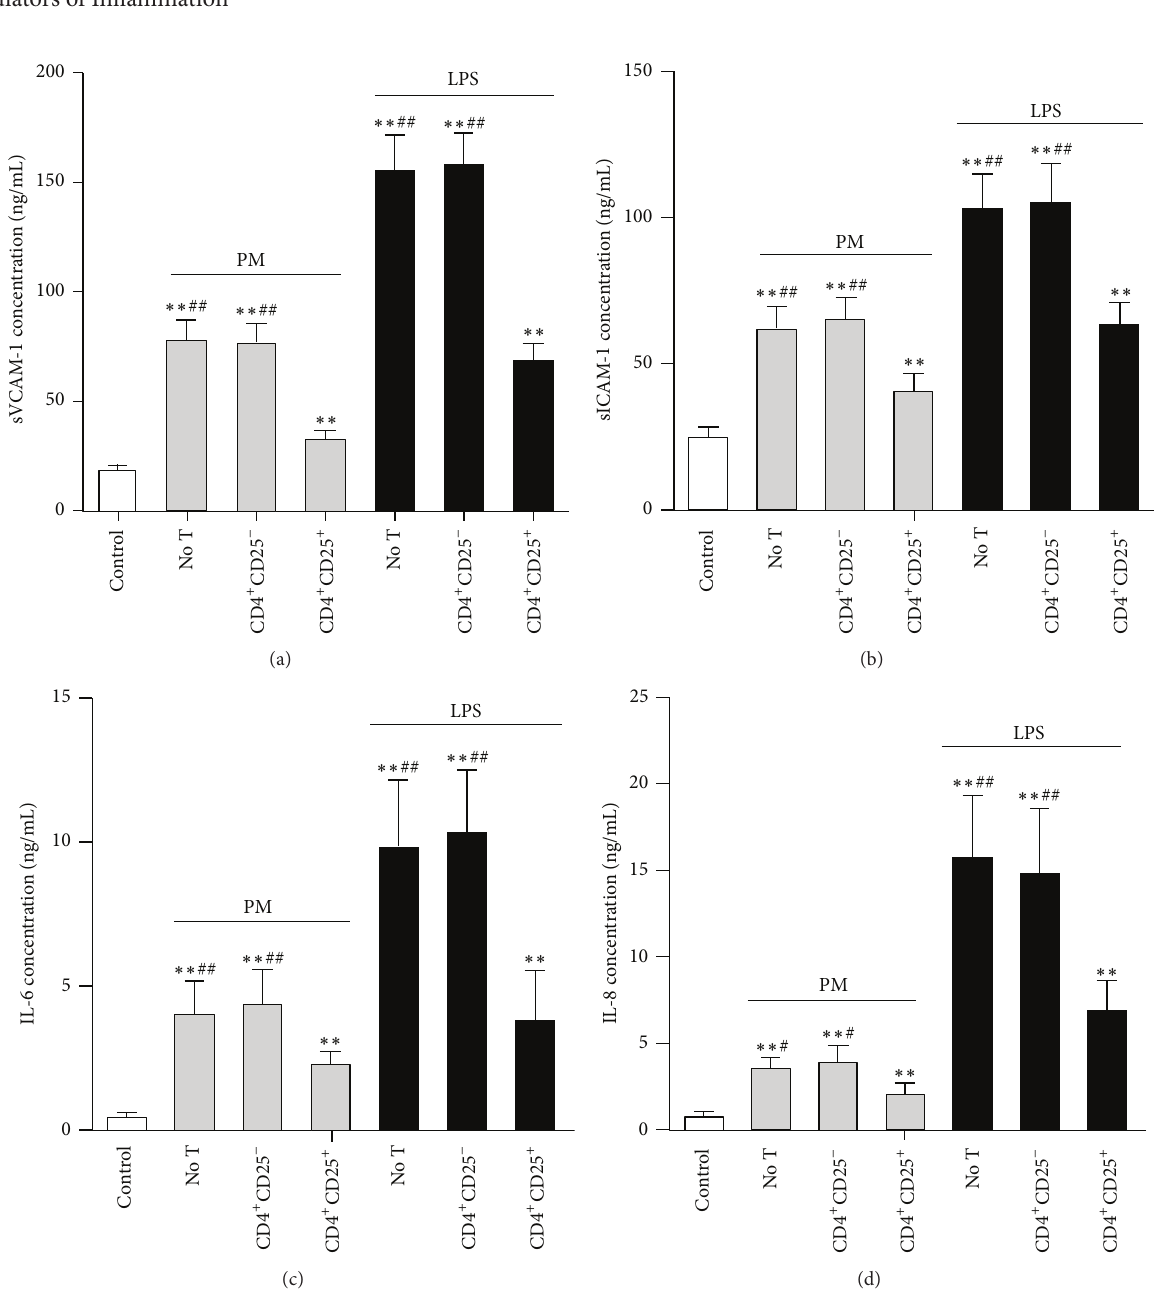
Figure 4: Tregs downregulate the protein expression of adhesion molecules and inflammatory cytokines in PM-exposed HUVECs. The ELISA assay was used to detect the concentration of sVCAM-1 (a), sICAM-1 (b), IL-6 (c), and IL-8 (d) in the supernatants from different groups of HUVECs. Data are expressed as means ± SEM. ∗ indicates no T, CD4 + CD25 − , or CD4 + CD25 + versus control; # indicates no T